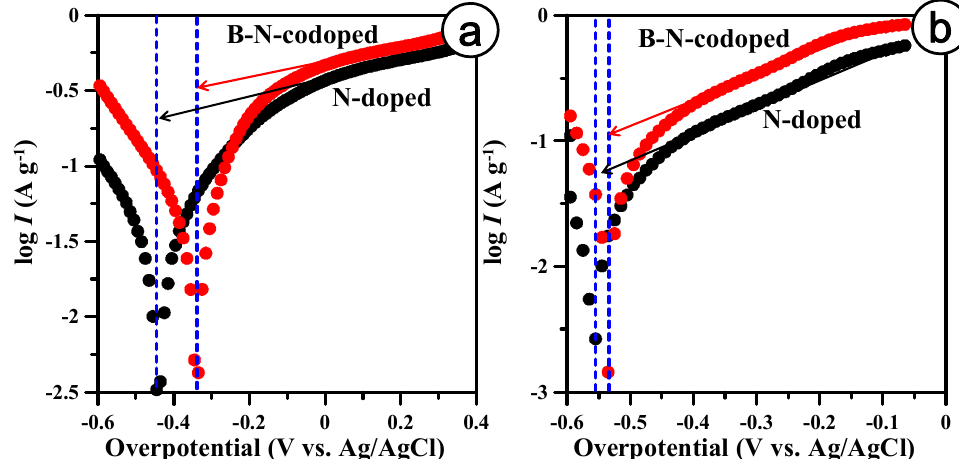
Figure 8. Typical Tafel plots of both N-doped GQD and B-N-codoped GQD electrodes in 1 M glucose + 1 M NaOH electrolyte at 50 mV s − 1 : ( a ) The positive scan and ( b ) negative scan. The arrow indicates their corresponding exchange current.